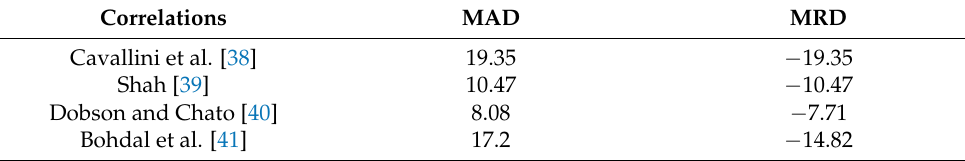
Table 3. The MAD and MRD of heat transfer coefficient for different correlations. Correlations